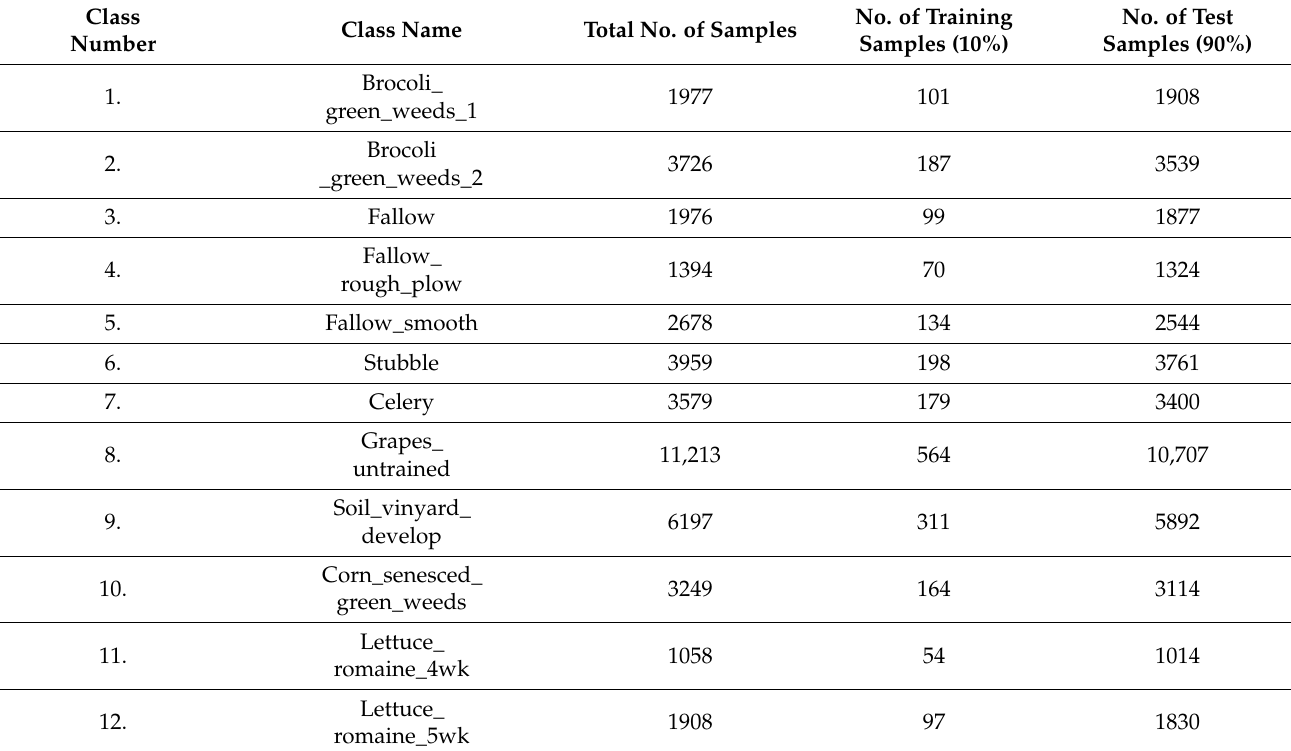
Figure 7. ( a ) Salinas dataset map; ( b ) color codes with scale bar (* is approximate scale of dataset). Table 3. Training and test samples of Salinas